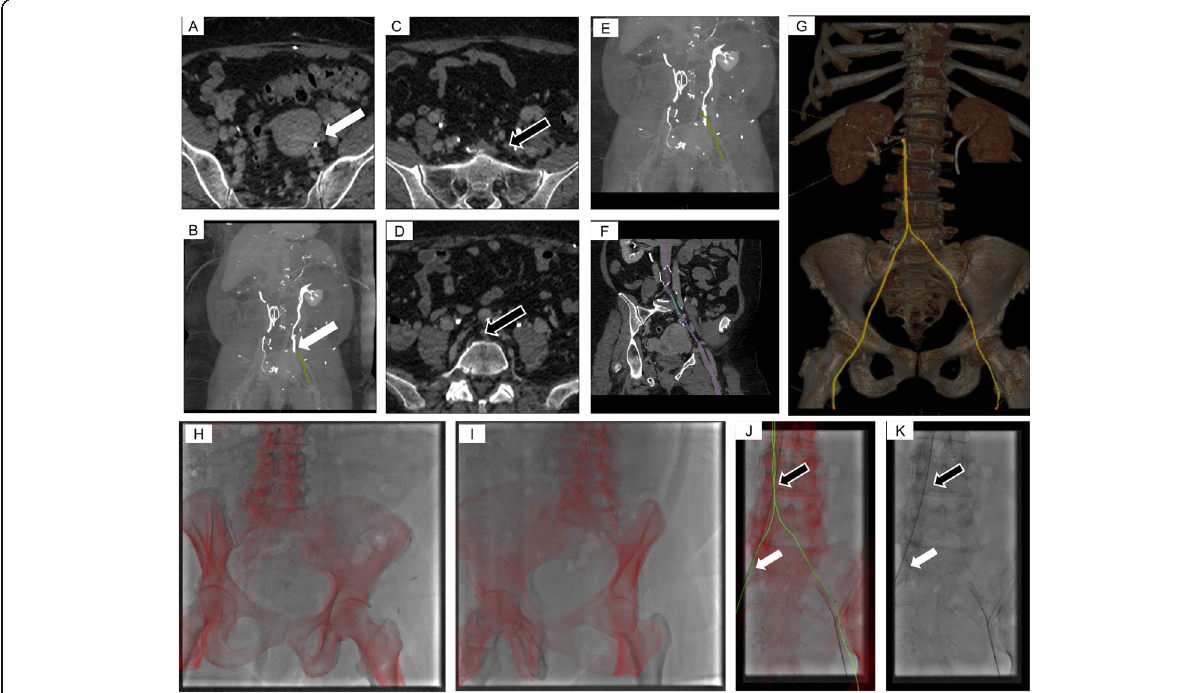
Fig. 1 Centerline creation and roadmapping step-by-step tutorial. Begin by distinguishing bone, vessel and calcification densities from the pre- operative CT and start building the centerline for the vessels of interest using the reformatted views ( a , white arrow on initial axial starting point). The centerline will start growing in 3D ( b , white arrow). Once the occlusion is reached, start a bridge and deposit multiple points throughout the occluded vessel until the re-entry point ( c - d ) to continue growing the line ( e ). Adjust the vessel centerline using a dedicated tool ( f ). Repeat the operation on other vessels if necessary ( g ). Before proceeding with intra-procedural vessel selection, an assisting x-ray technologist fuses the pre- operative data on live fluoroscopic images using a Bi-View guided workflow all at tableside. Registration is performed by cross-referring fixed fluoroscopic landmarks (in this case, pelvic and spinal bones) with the same osseous landmarks on CT using only 2 fluoroscopic images approximately 50 – 60 degrees apart (in this case, RAO 15 ( h ) and LAO 40 ( i ). After initial registration, the vessel centerlines are displayed to the user ( j ), providing guidance to navigate the catheter compared to the standard fluoroscopy image ( k ). Dynamic adjustments to the registration are performed as needed by adjusting the red bony landmark overlays. Note that the occluded right common iliac vein (white arrow) and infrarenal inferior vena cava (black arrow) have already been crossed without contrast instillation using this